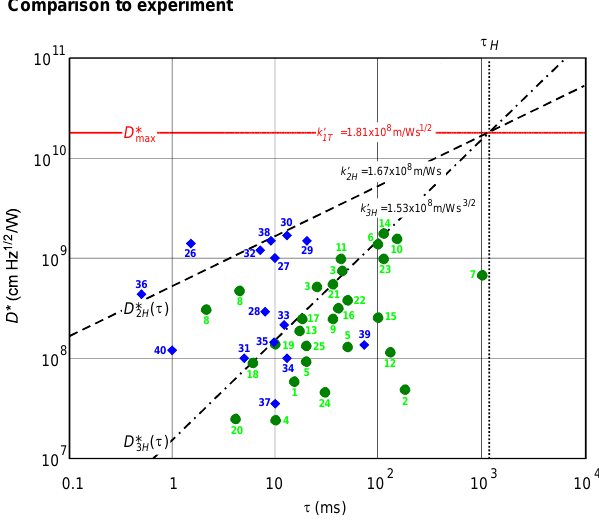
Figure 3. Parameters D ∗ and τ of a selection of commercial as well as non-commercial thermoelectric ( • ) and bolometric ( (cid:7) ) radiation sensors and sensor arrays operated at room temperature. For the tag numbers cf. Tables 3 and 4. D ∗ ( τ ) is the specific detectivity max due to the thermodynamic limit (solid line), D ∗ ( τ ) the one due to 2H Havens’ limit related to type II detectors (dashed line) and D ∗ ( τ ) 3H the one due to its type III detector analogue (dot-dashed line). τ H is the maximum time constant within Havens’ limit (dotted line).